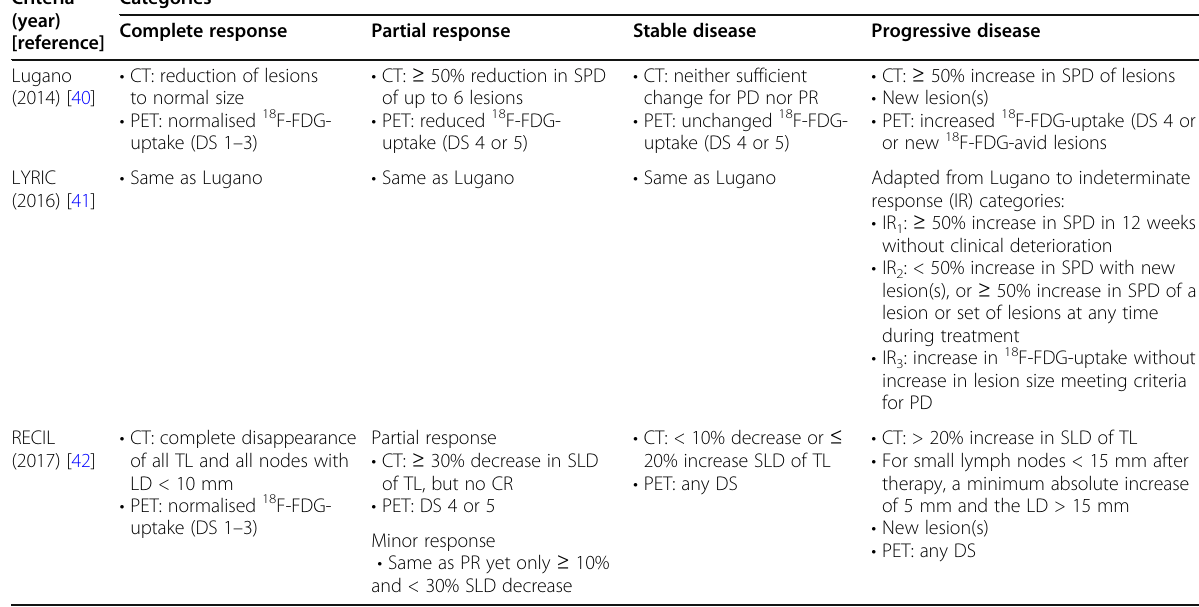
Table 4 Overview of response criteria for lymphoma Criteria (year)